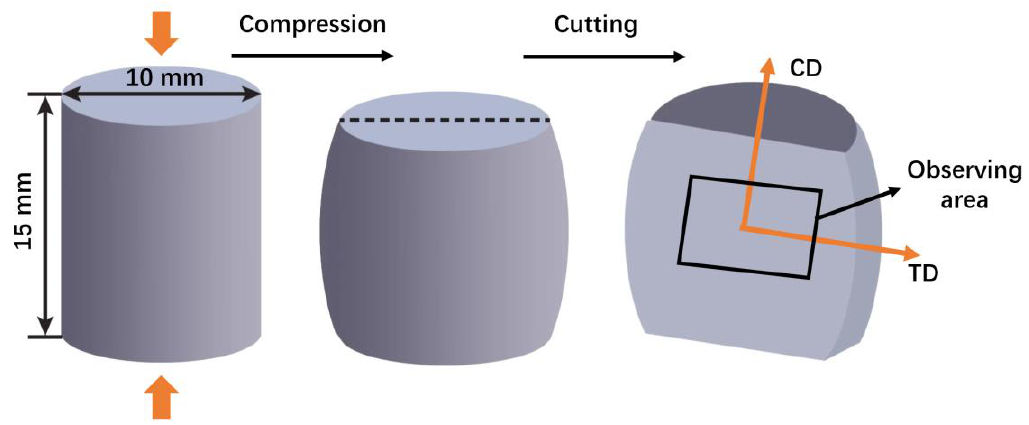
Figure 1. The compression scheme and EBSD sample coordinate